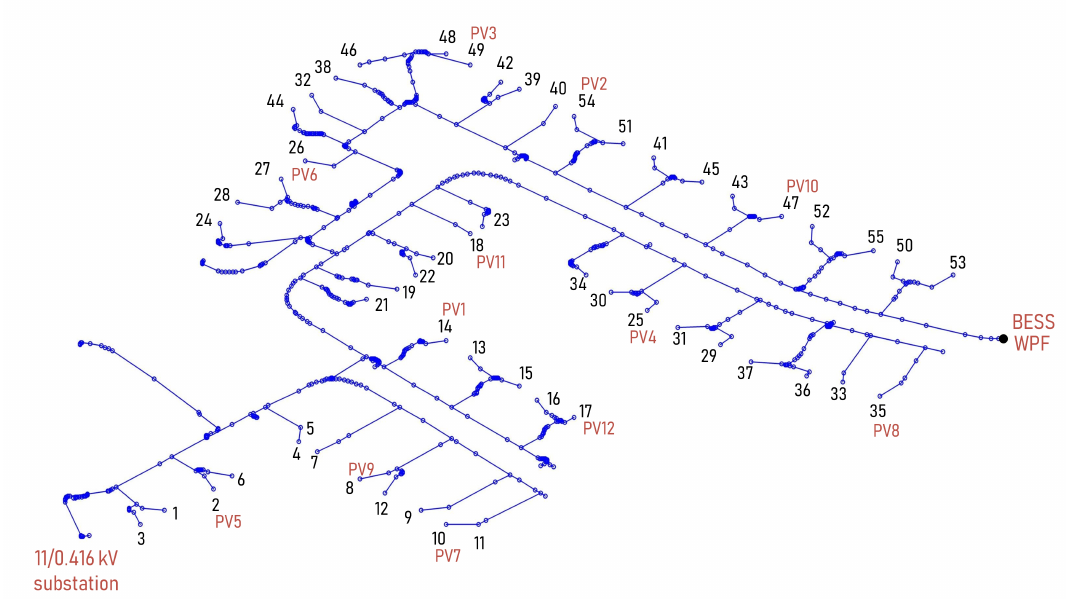
Figure 11. One-line diagram of the